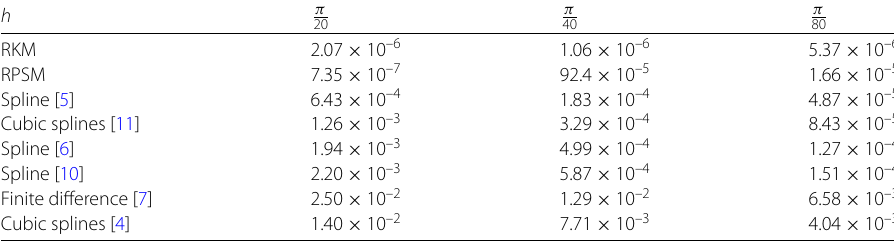
Table 3 Numerical comparison via maximum absolute error at α = 2